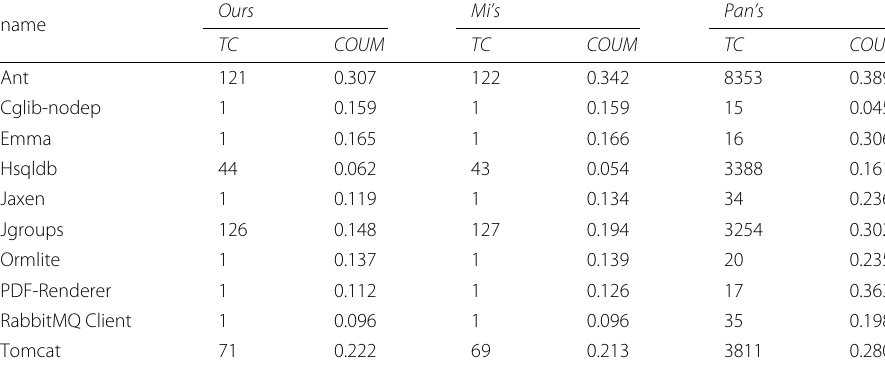
Table 3 Comparison of refactoring